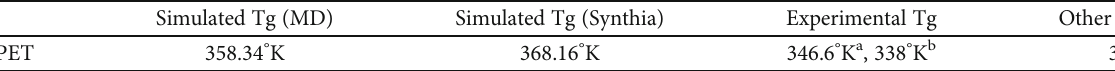
Table 1: Simulated and experimental Tg of